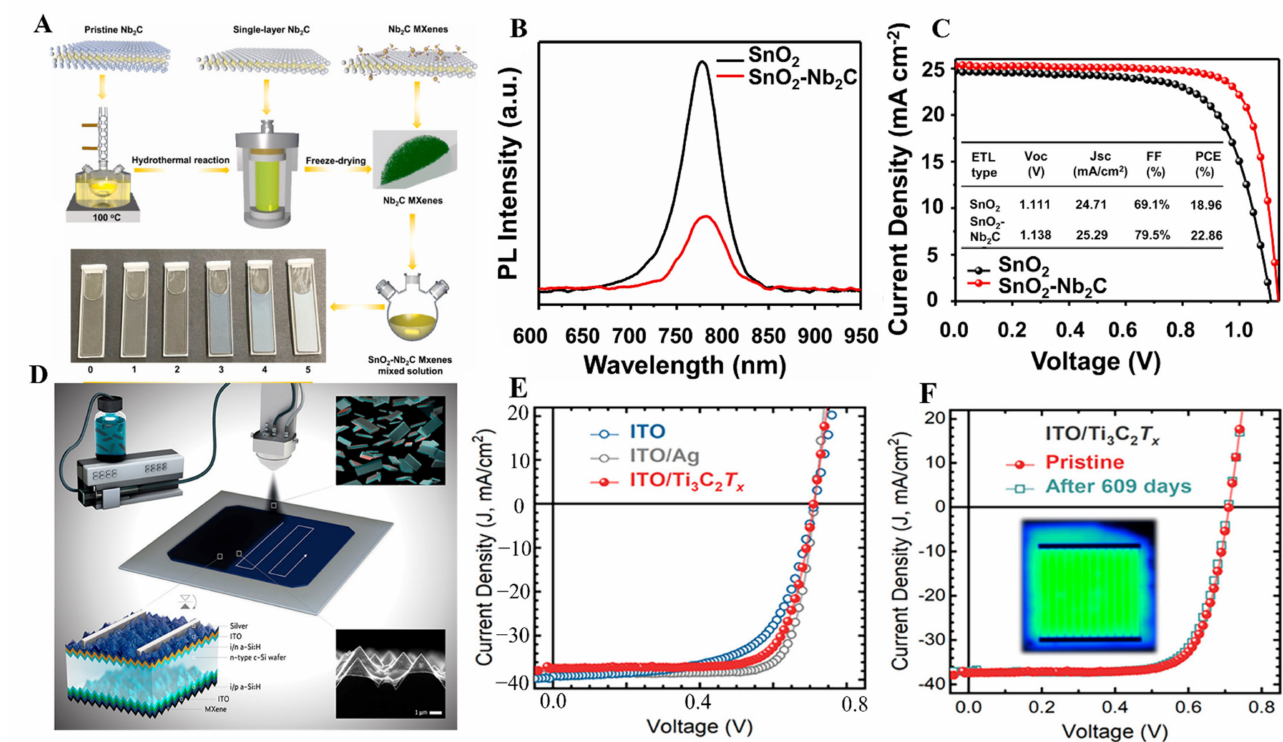
Figure 14. ( A ) The preparation process of SnO 2 -Nb 2 C MXene solution; ( B ) Photoluminescence spectra of SnO 2 and SnO 2 -Nb 2 C MXene; ( C ) J-V curves, and photoconversion efficiency of SnO 2 and SnO 2 -Nb 2 C MXene thin films fabricated by an SCM, reproduced with permission [124]. Copyright 2020, American Chemical Society); ( D ) Schematic representation of the automated spraying apparatus of large-scale deposition of Ti 3 C 2 T x flakes as the back electrode for SHJ solar cells, Insets: (Bottom-left) Corresponding layer-by-layer structure of an SHJ solar cell. (Bottom-right) Tilted top-view SEM micrograph of the Ti 3 C 2 T x flakes covering the ITO-coated pyramidal textured surface of SHJ solar cells; ( E ) JV curves of ITO, ITO/Ag, and ITO/MXene thin films; ( F ) JV curves after 609 days of a device fabricated (reproduced with permission [166]. Copyright 2020, American Chemical